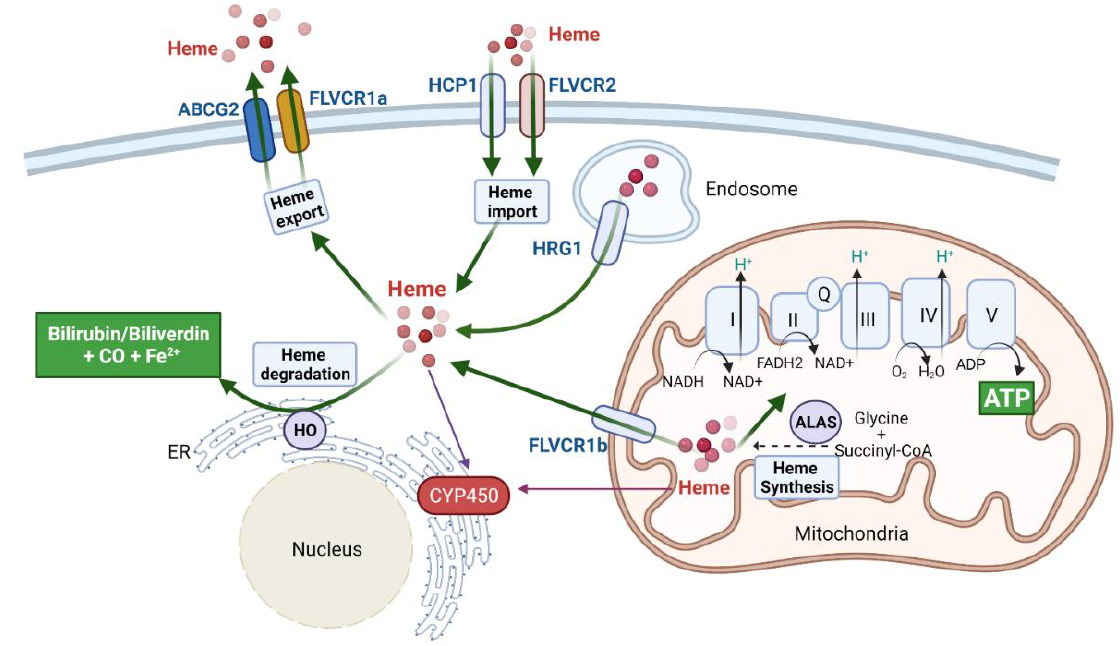
Figure 1. Heme metabolism in human cells. Human cells acquire heme in two ways. (1) Heme biosynthesis involves multiple enzymes that progressively convert glycine and succinyl-CoA to heme. (2) Heme uptake from the circulation to enterocytes is facilitated via heme importers HCP1/SLC46A1 and FLVCR2. Neuronal, hepatic, and red blood cells can directly take up heme from the bloodstream via HRG1. Heme serves as a prosthetic group in proteins involved in oxygen storage and usage, such as cytochrome P450. Heme degradation is carried out in the endoplasmic reticulum via HO. Heme exporters ABCG2 and FLVCR1a export heme out of cells to maintain cell heme level. (Created with BioRender.com).